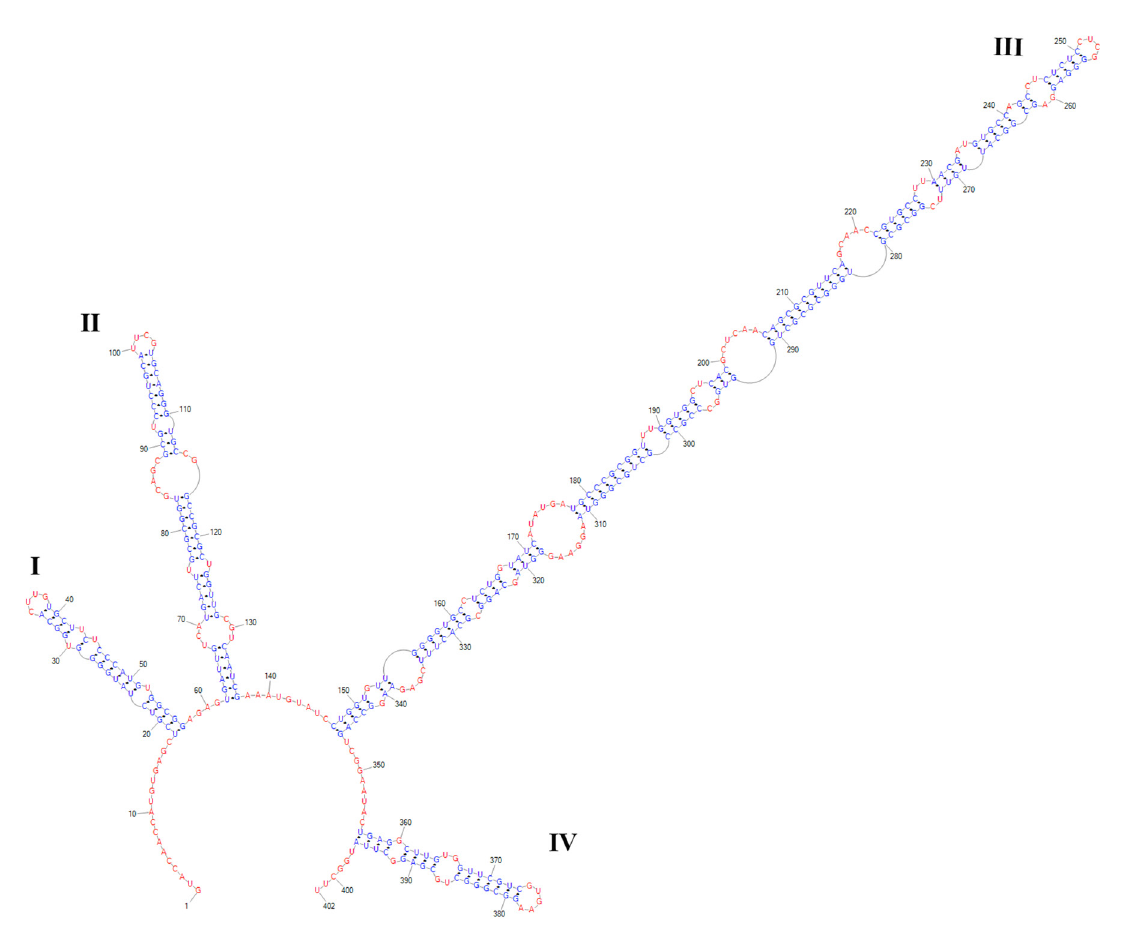
Fig. 14. Predicted secondary structure of the nuclear internal transcribed spacer 2 of the strain UR168 (from 5’ to 3’ terminus in clockwise